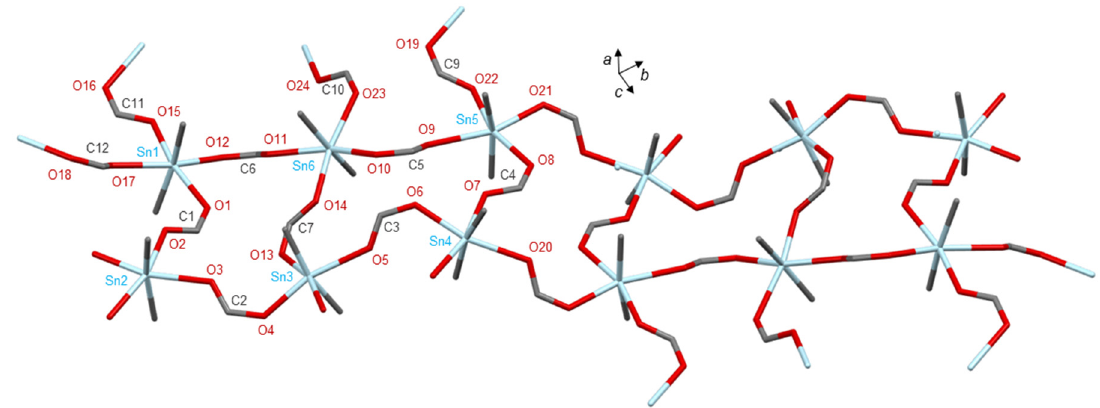
Figure 8. Polymeric structure of [ n -Bu 2 Sn(O 2 CH) 2 ] n (CCDC ref.: EKONEY, 783726), adapted from [60] (MERCURY view). Hydrogen atoms are omitted for clarity and for each n -butyl chain; only the α -carbon atoms bonded to tin are shown (Sn light blue, O red, C grey).